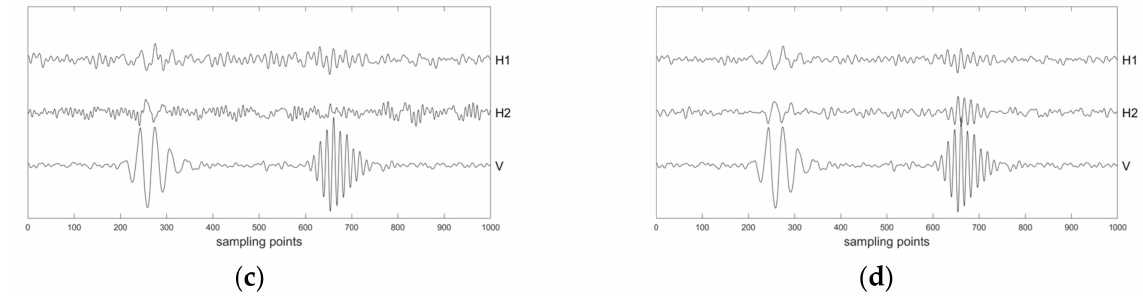
Figure 7. Denoising results of the synthetic microseismic data. ( a ) The synthetic data without noise. ( b ) The synthetic data with noise. ( c ) The denoising result of VMD. ( d ) The denoising result of re-constrain VMD.